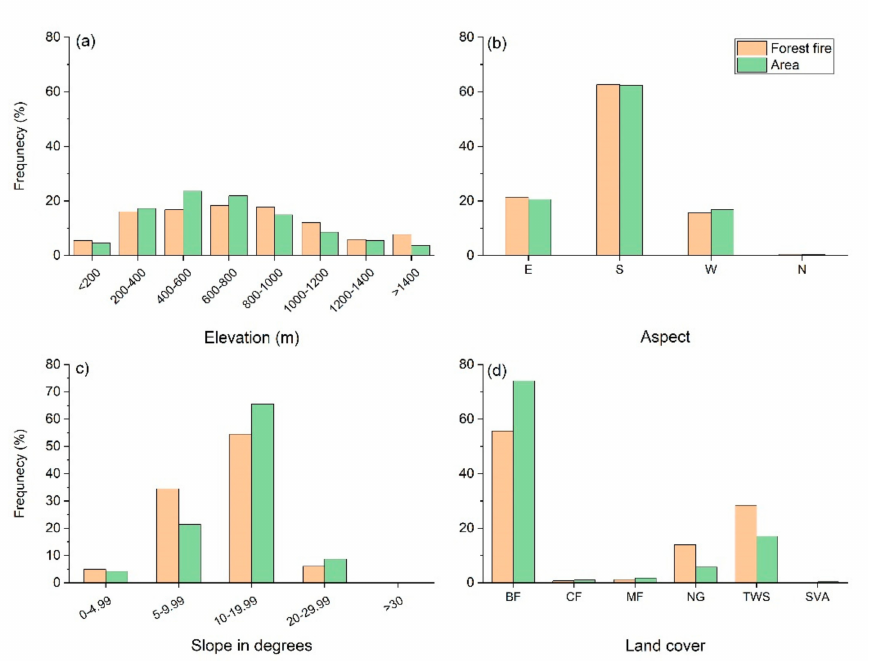
Figure 3. Frequencies of forest fires and areas covered by categorical variables: ( a ) elevation classes, ( b ) aspect classes (exposure), ( c ) slope degree classes, and ( d ) vegetation classes obtained from CORINE land cover 2012 that are present in Eastern Serbia: BF: broad-leaved forest; CF: coniferous forest; MF: mixed forest; NG: natural grasslands; TWS: transitional woodland-shrubs, and SVA: sparsely vegetated